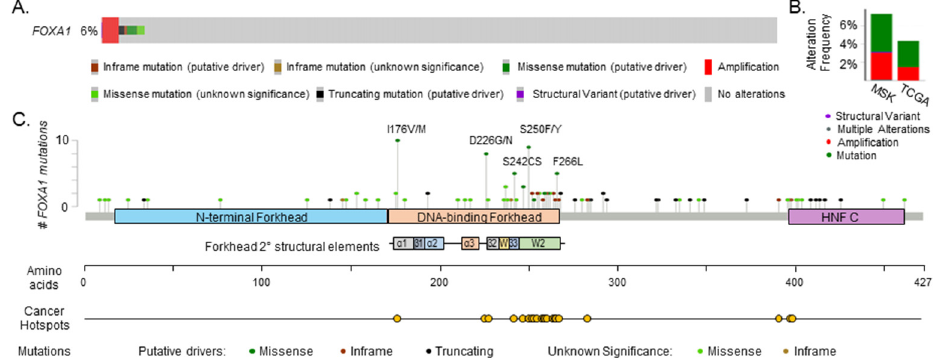
Figure 2. Amplification, mutation, and structural variation of the FOXA1 gene in breast cancer patients. ( A ) Oncoprint depicting FOXA1 genetic alterations in 3002 primary and metastatic breast cancer samples (all subtypes) from 2840 patients analyzed by Memorial Sloan Kettering [79,82], and The Cancer Genome Atlas (TCGA PanCancer) [78], ( B ) FOXA1 alteration frequency segregated by study, ( C ) Lollipop plot showing FOXA1 mutations and clustered hotspot mutations in the fkh DNA-binding domain of FOXA1 in MSK and TCGA samples and adapted from [79] . Data analysis was conducted with www.cbioportal.org accessed on August 12, 2021.